Question: Write a single sentence explaining what this figure depicts.
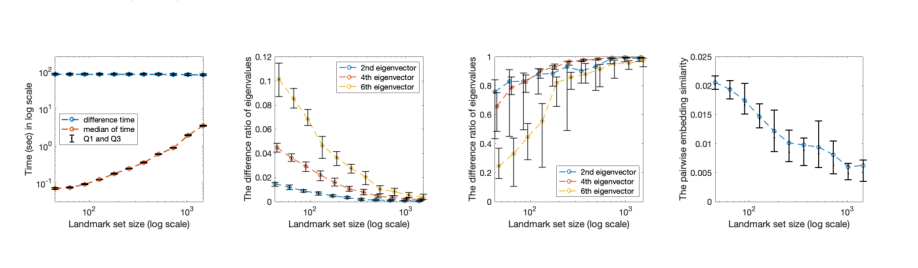
Answer: From left to right: a comparison of computational time between AD and 1/2-LAD with different landmark sizes, the dif- ference ratio of the 1st, 3rd, 5th non-trivial eigenvalues between AD and 0.5-LAD, the inner product between the 1st, 3rd, 5th non-trivial eigenvectors of AD and 0.5-LAD, where we plot top 6 non-trivial eigenvectors, and the embedding similarity between AD and 0.5-LAD.